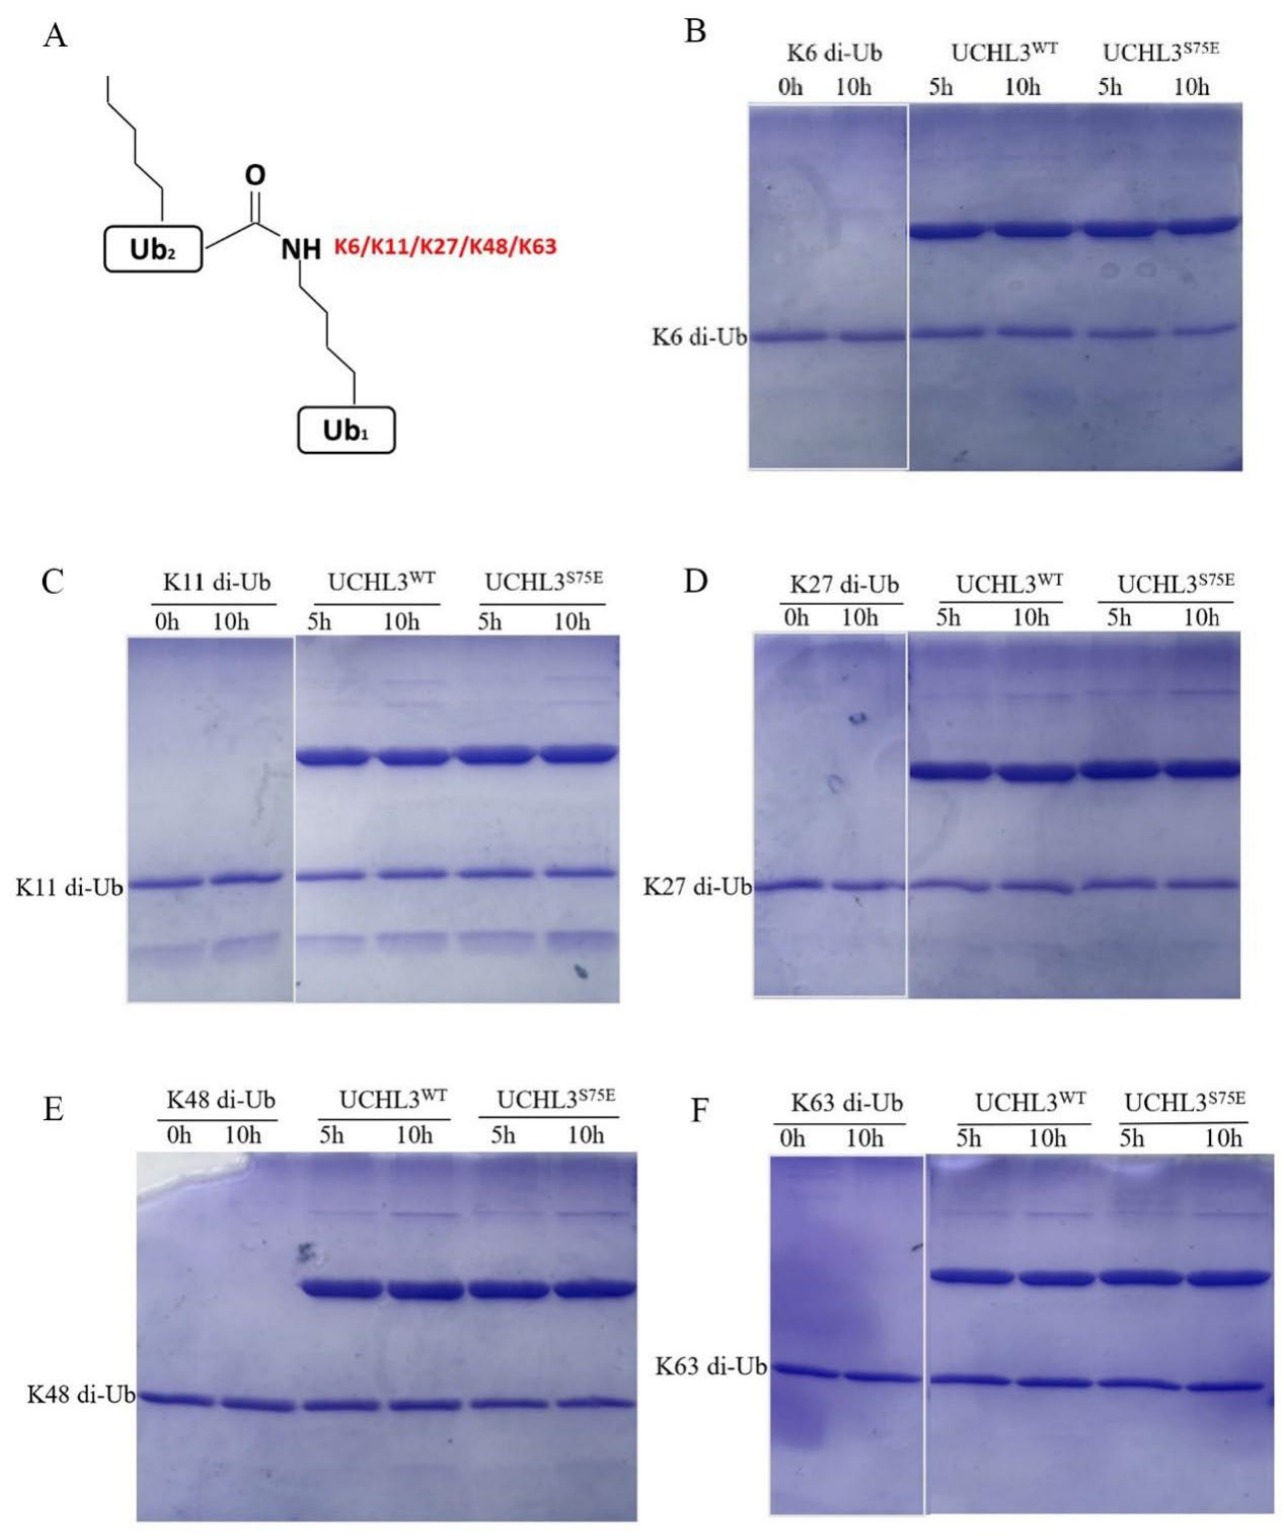
Figure 4. Hydrolysis activity of UCHL3 toward different types of di-Ub. ( A ) Pattern diagrams of different types of synthesized di-Ub (K6, K11, K27, K48, K63). ( B – F ) UCHL3 was incubated with different types of di-Ub, and the reaction products were fractionated via sodium dodecyl sulfate-polyacrylamide gel electrophoresis (SDS/PAGE) and visualized by Coomassie Blue staining.